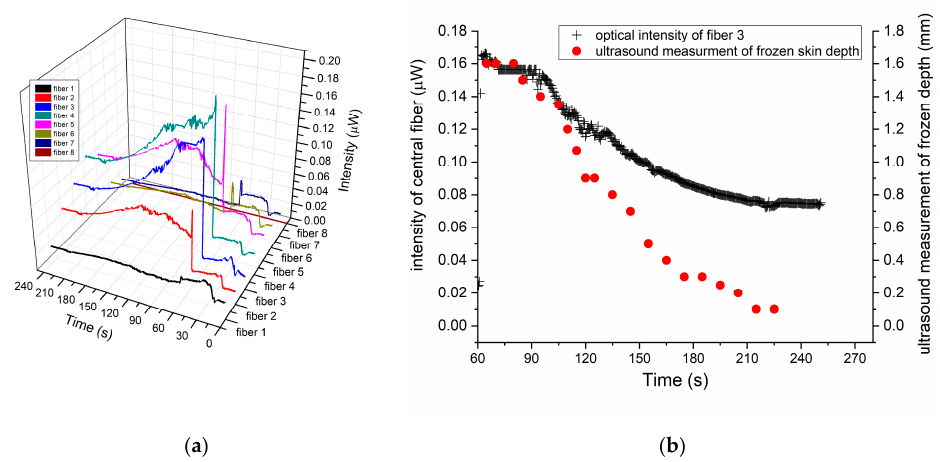
Figure 12. ( a ) Intensity timeline; ( b ) optical intensity and frozen tissue depth using ultrasound.